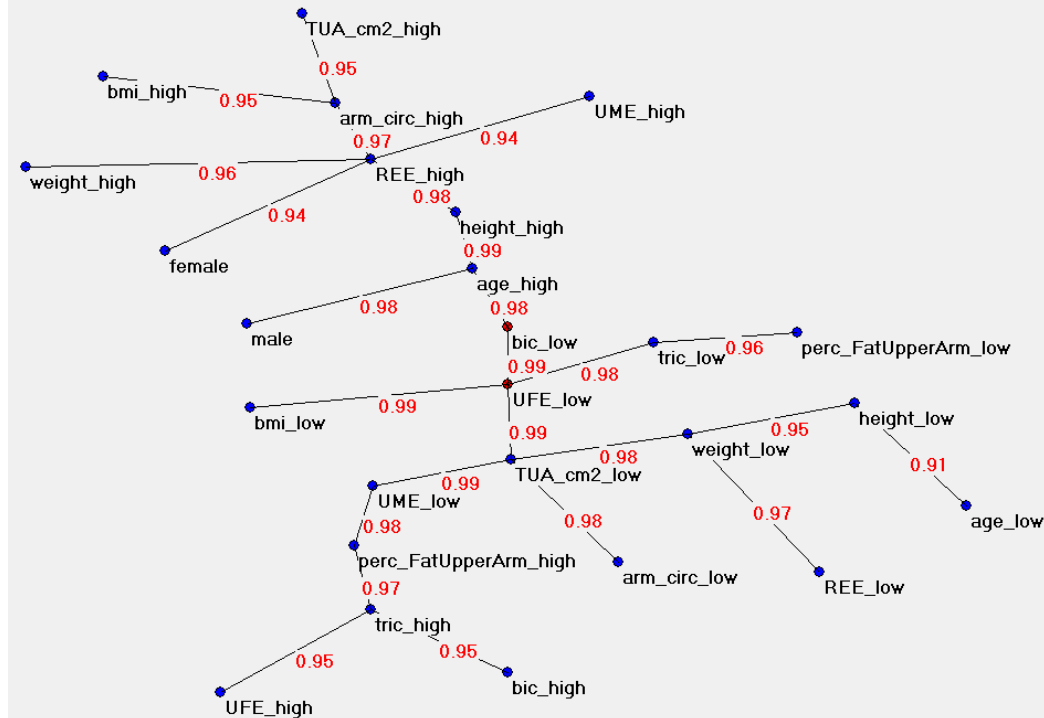
Figure 1. Semantic connectivity map of the 13 variables used for artificial neural network (ANN) modeling. Semantic connectivity map of the variables under study in the study group with the Auto Contractive Map (Auto-CM) system. The values on the arcs of the graph indicate the strength of the connection, measured on a scale ranging from zero to 1. TUA: total upper arm area; UME: upper arm muscle area estimate; UFE: upper arm fat area estimate; TUA: total upper arm area; perc_fat_upperarm: arm fat percentage; arm_circ: arm circumference; tric: triceps skinfold; bic: biceps skinfold; REE: resting energy expenditure.